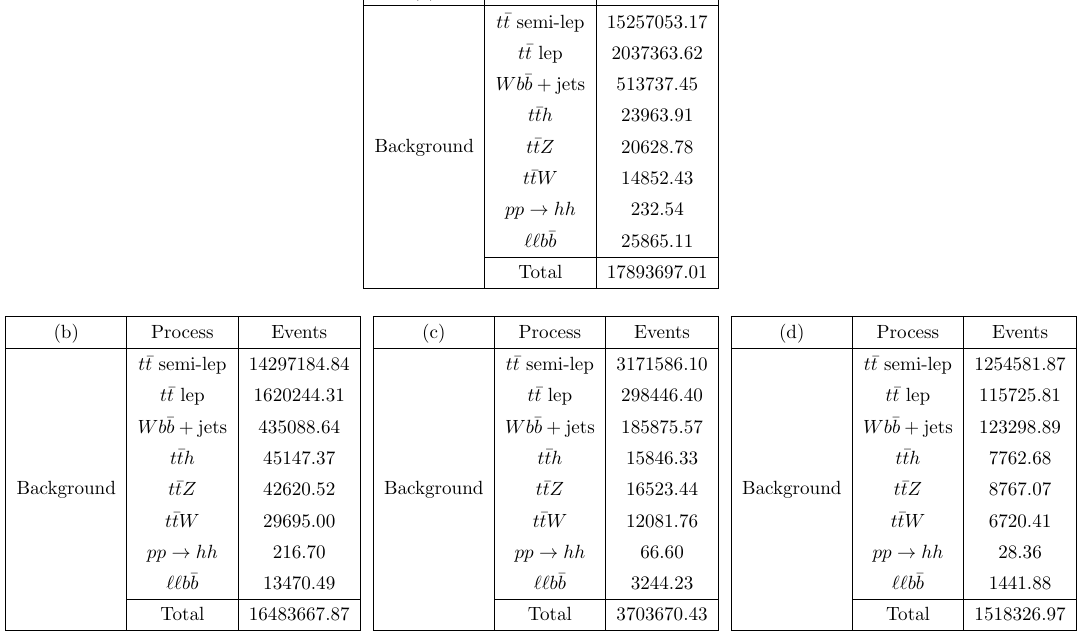
T channel after the BDT analyses